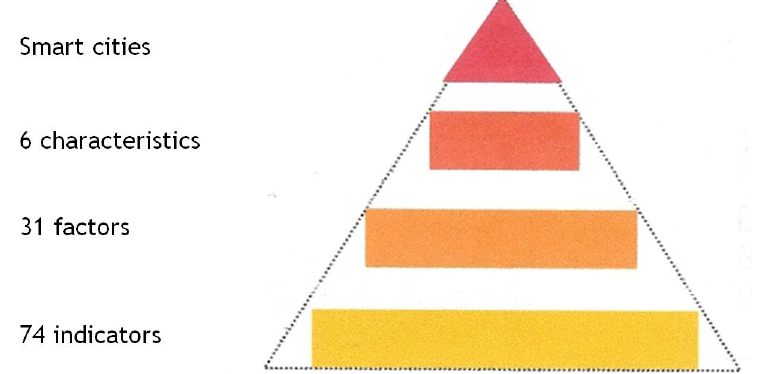
Figure 9. Elements describing a smart city (based on which the chart in figure 10 is set).